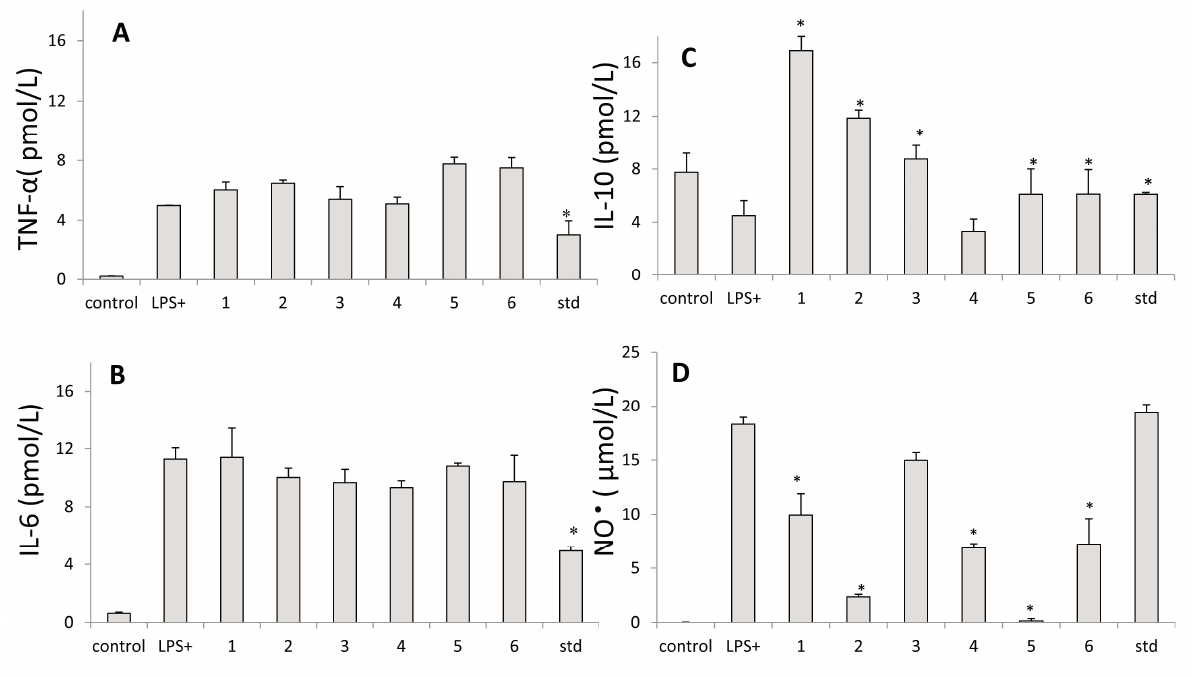
Figure 2. Effect of the isolated diterpenic acids on nitric oxide (NO • ) and cytokine production in lipopolysaccharide-stimulated J774 cells. ( A ) TNF- α , ( B ) IL-6 and ( C )